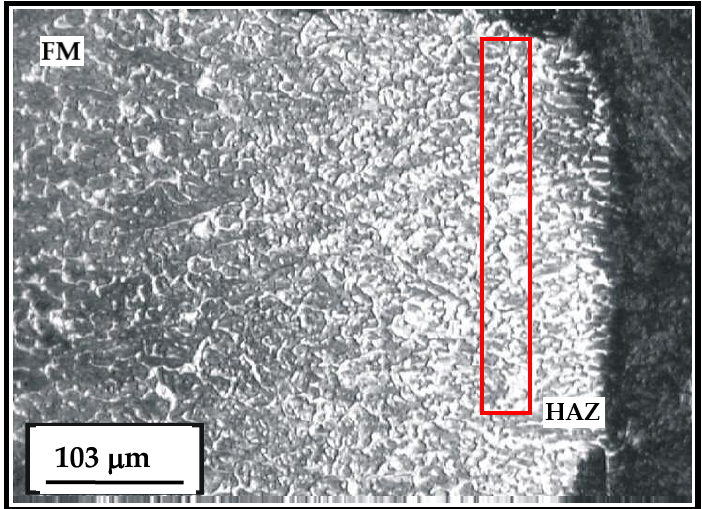
Figure 11. Microstructure of the hard-faced layer executed by the FM Tooldur (light area) and HAZ (dark area); the red-framed area is the zone of the largest portion of the carbide phase.